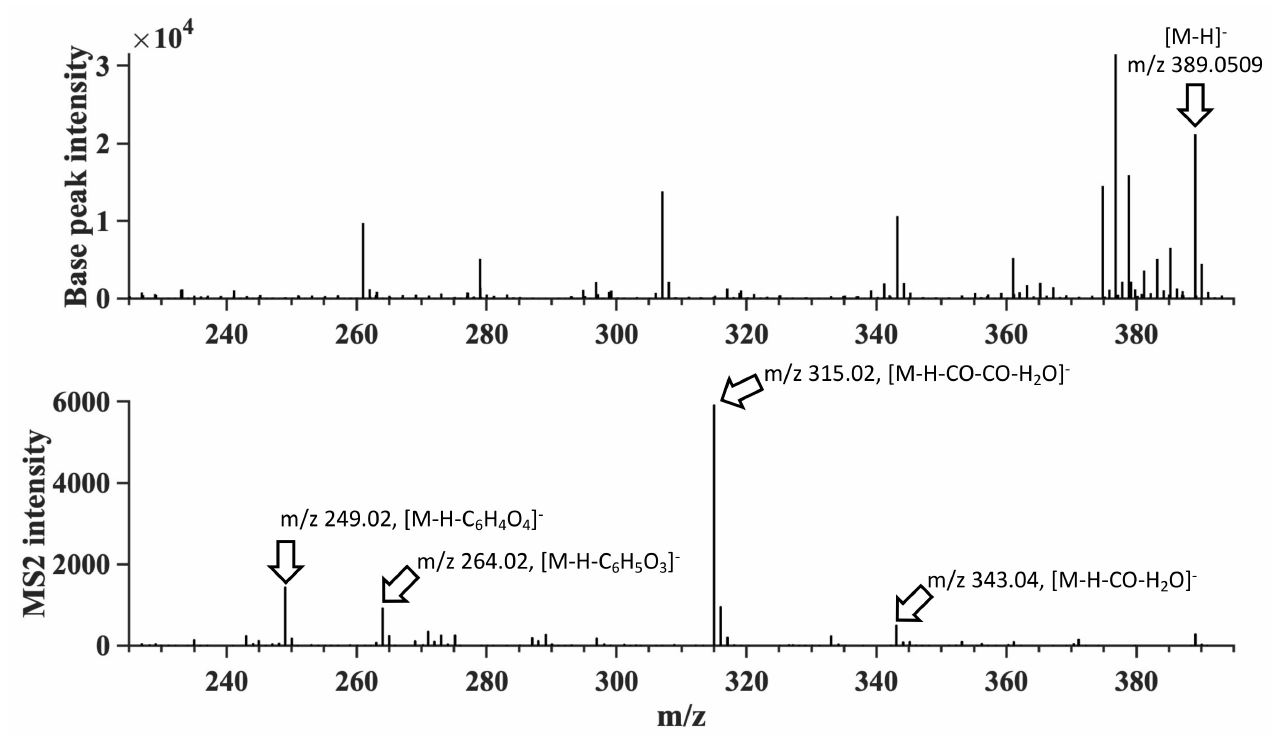
Figure 5. MS 1 and MS 2 spectra of m / z 389.0509 found in A. nodosum